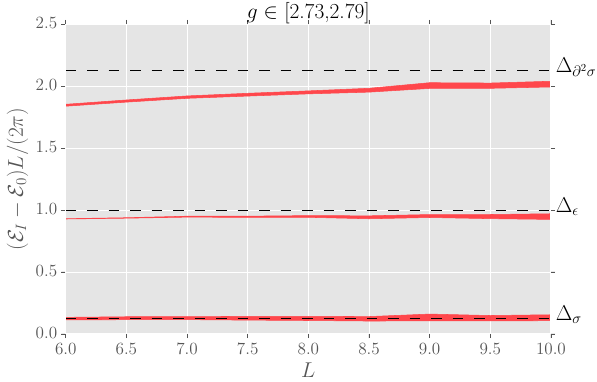
Figure 4 . Energy levels at g = g c vs CFT